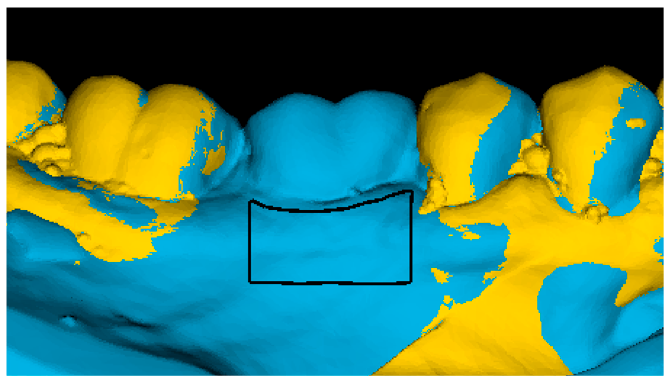
Figure 2. The digital surface model at T0 (yellow) and the digital surface model at T4 (blue) were superimposed. The area of interest (black box), located at the buccal aspect of the grafted area, was determined on the T4 model with the definitive crown in situ.